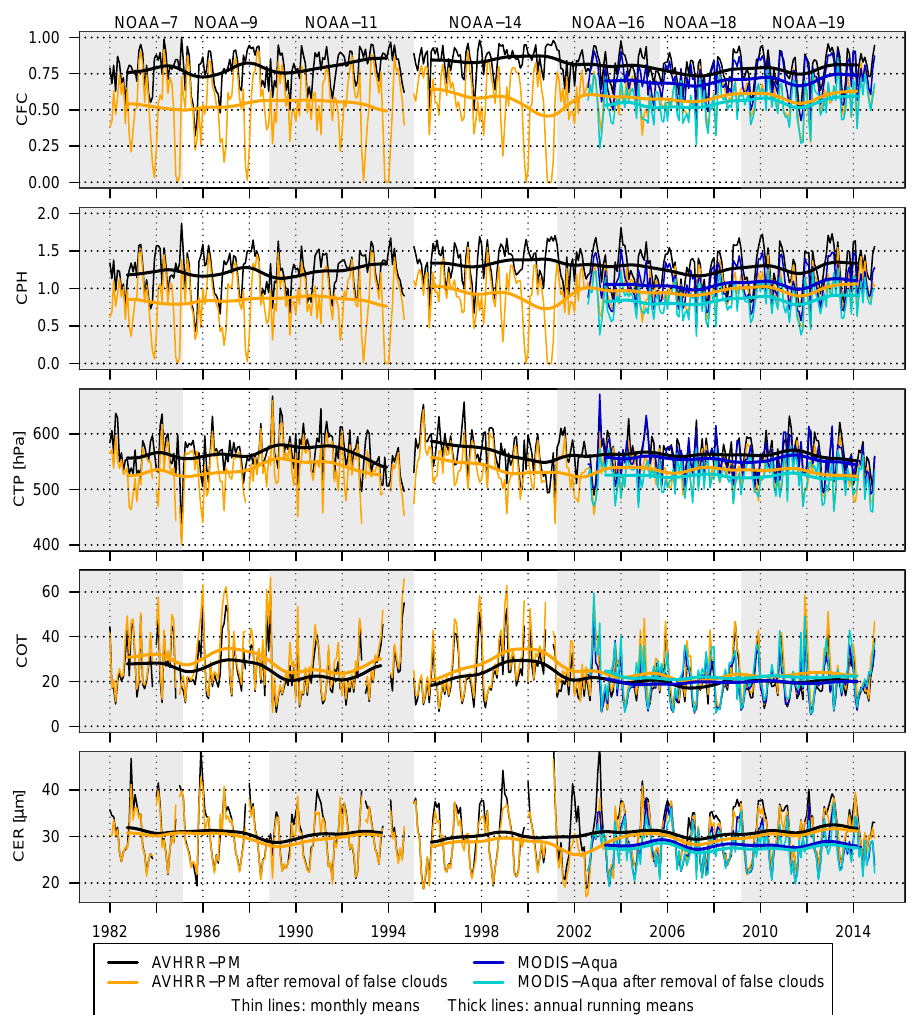
Figure 11. Time series of monthly means (thin lines) and annual moving averages (thick lines) of cloud properties, before and after removing points flagged by the model as potential false positives. Nine SYNOP stations located above 1000m are averaged together. CFC stands for cloud fractional cover, CPH for cloud phase (0: no cloud; 1: liquid phase; 2: ice phase), CTP for cloud top pressure, COT for cloud optical thickness, and CER for cloud effective